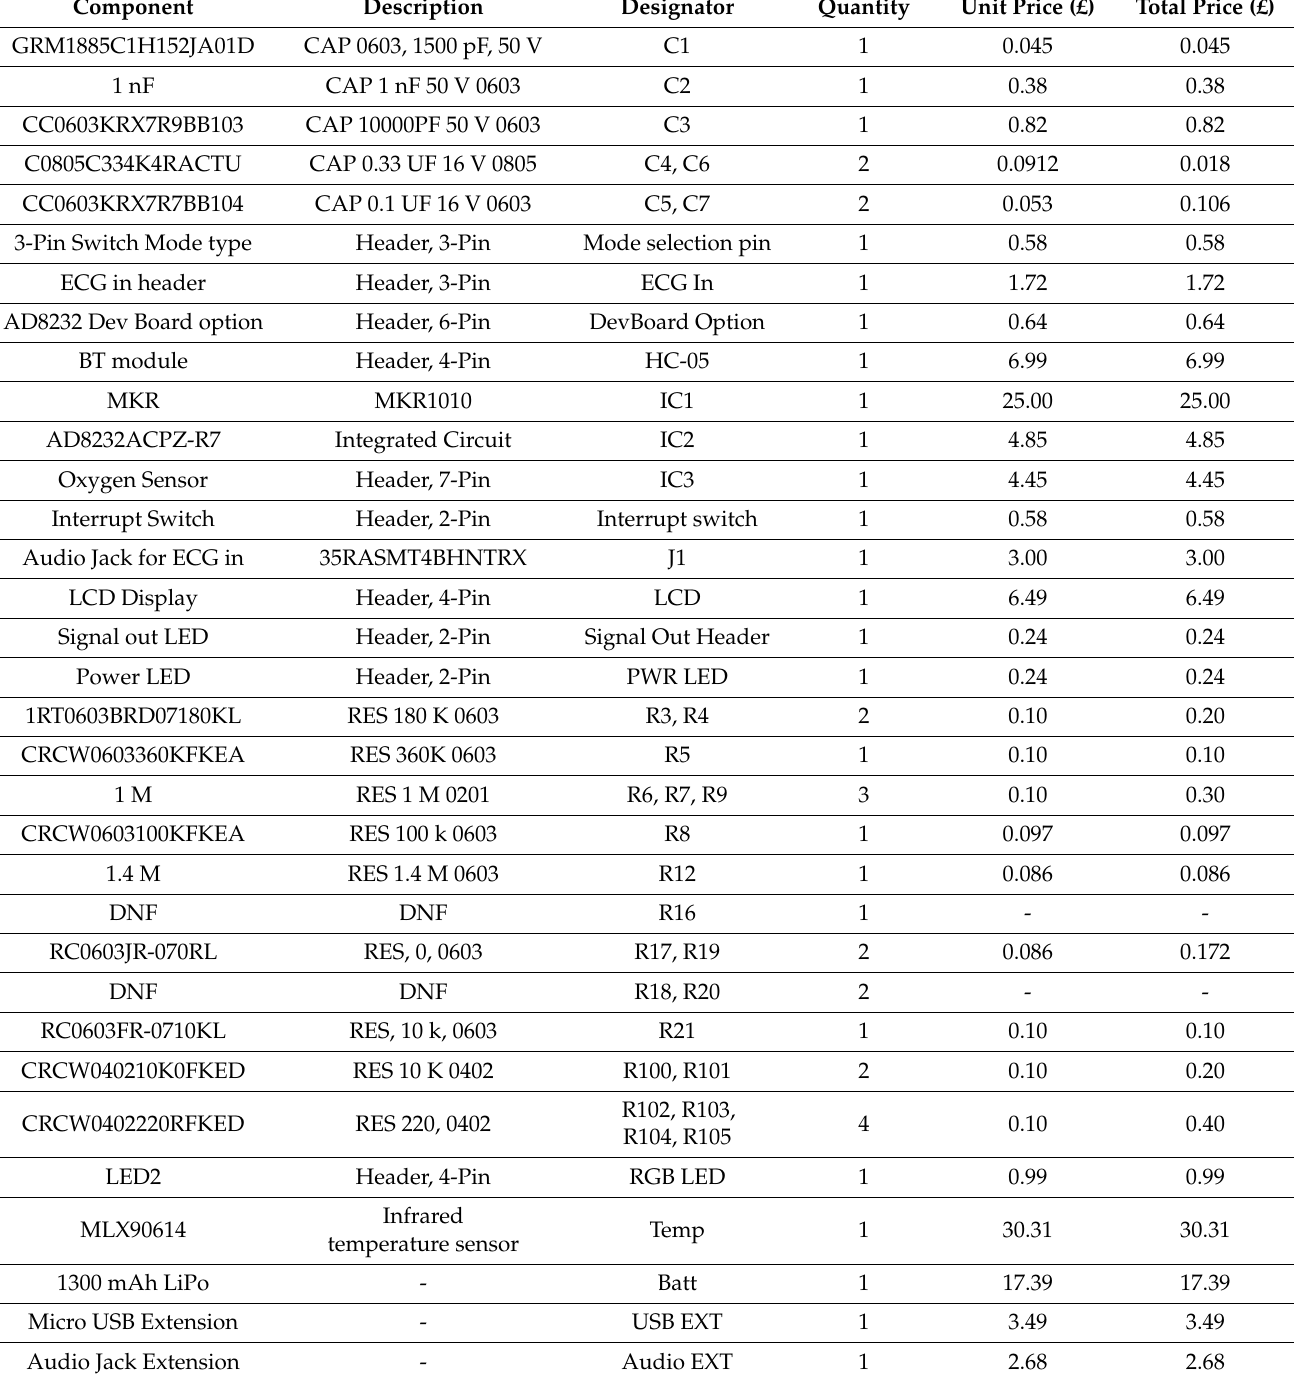
Table 6. Electronic components